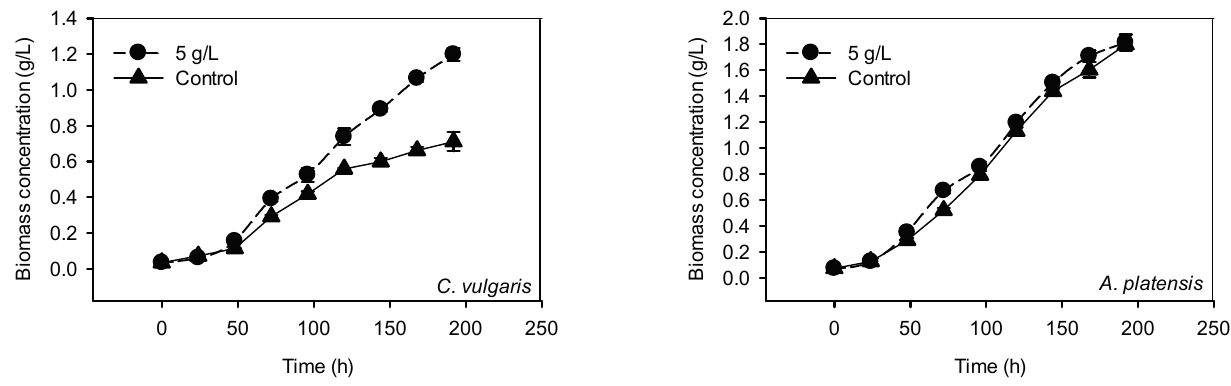
Figure 7. Biomass production during the cultivation of C. vulgaris and A. platensis in cultivation media supplemented with 5 g/L P-loaded zeolite as P